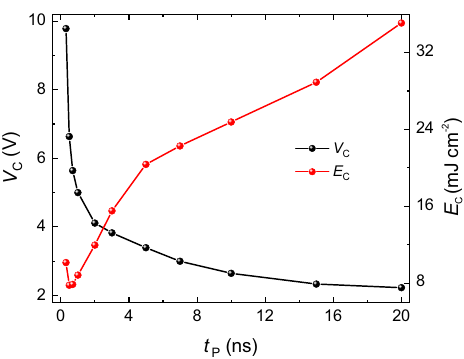
Fig. 5 Switching with short pulses. Threshold switching voltage (black dots, left scale) and energy density (red dots, right scale) as a function of the pulse length. The critical switching voltage is determined by